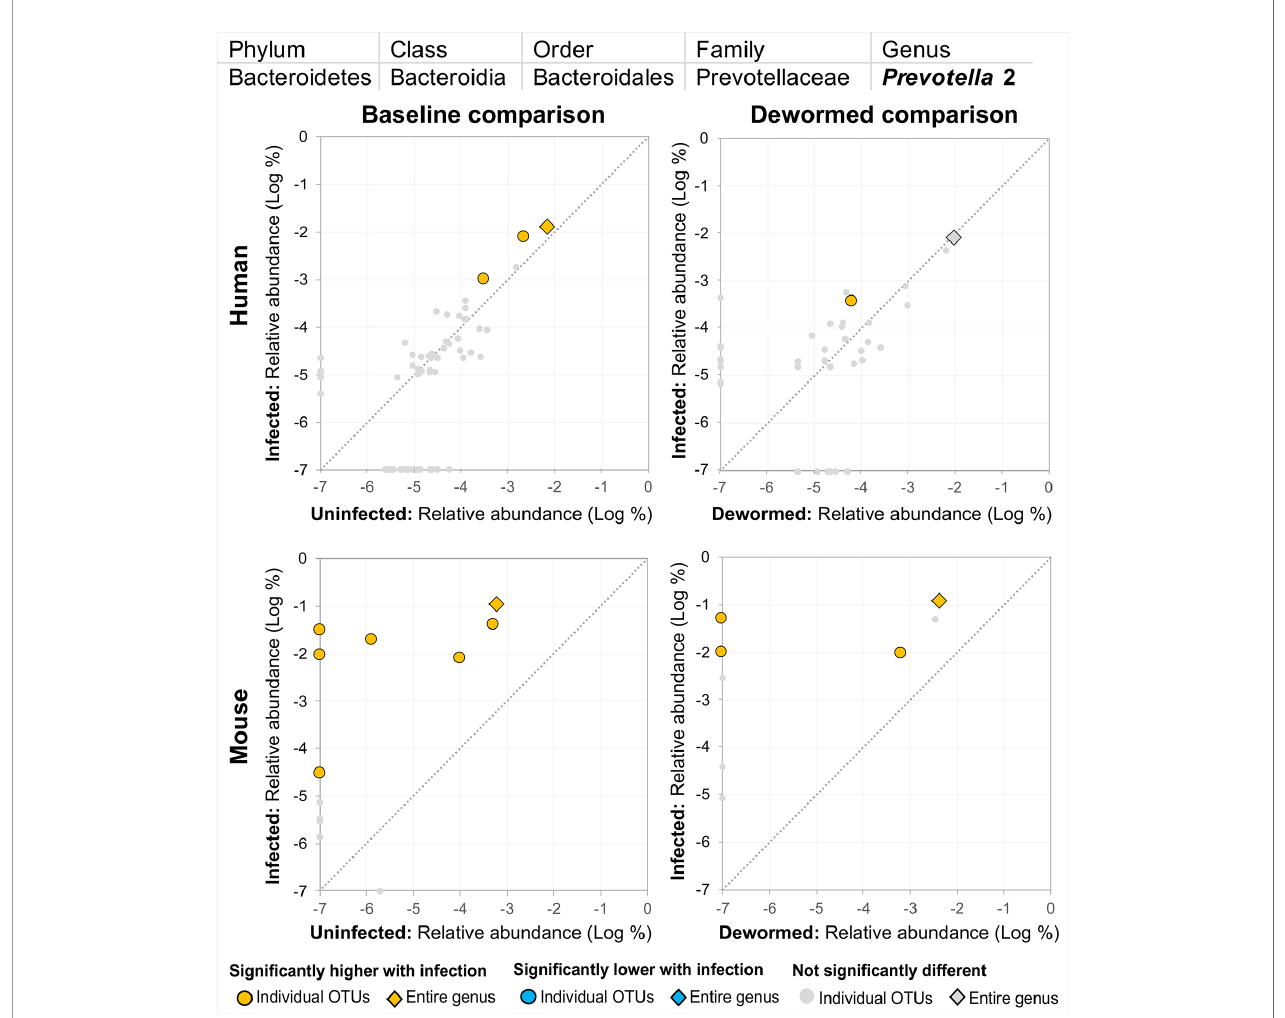
FIGURE 5 | The relative abundance (%) of all Prevotella 2 (genus) OTUs in each differential comparison among samples from whipworm-infected and uninfected humans and mice. Signi fi cant differentially abundant OTUs in each comparison (as identi fi ed by LEfSe) are colored in orange (higher with infection) and blue (lower with infection). The sum of all OTUs in the genus is represented with a diamond symbol. This is one of four genera with at least one OTU signi fi cantly higher in infection in all four